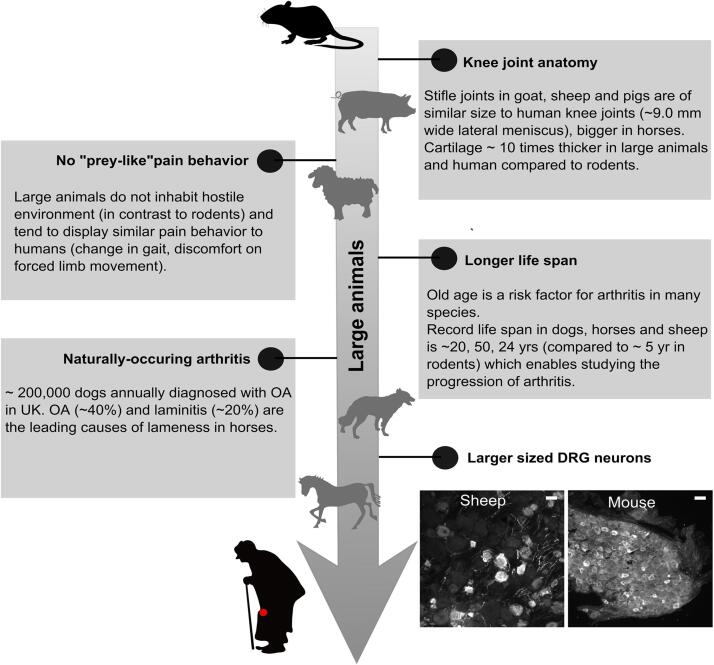
Schematic diagram emphasizing the potential for large animals in translational arthritic pain research. Large animals have similar sized knee and cartilage thickness compared to humans (McCoy, 2015, Proffen et al., 2012), longer lifespan (Carey and Judge, 2000), and larger DRG neurons compared to rodents (brighter neurons indicate CGRP immunoreactivity, Scale bar = 50 um). Unlike rodents which are prey species (Rice et al., 2008), large animals are less likely to hide pain behavior and are susceptible to naturally-occurring arthritis (mostly OA) similar to humans (K. L. Anderson et al., 2018; Centers for Disease Control and Prevention, 2015, Slater, 2016).